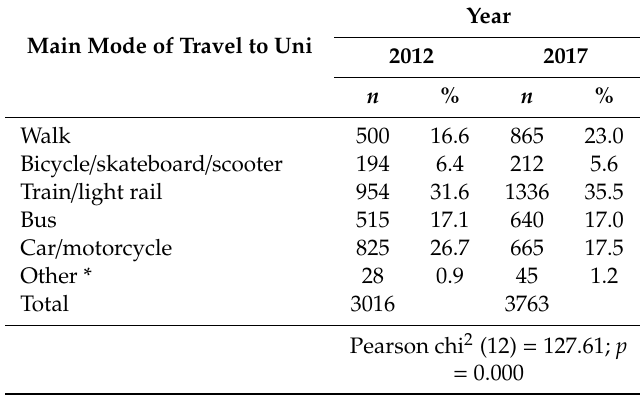
Table 3. Reported main mode of travel to university on travel survey day in 2012 and 2017.